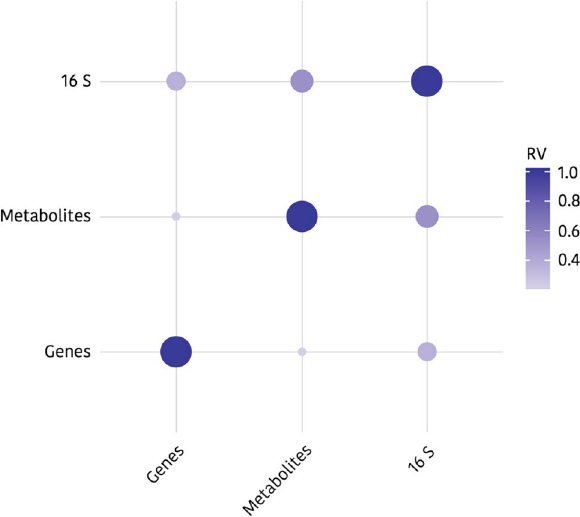
Figure 6. Correlation plot between gene expression (Genes), caecal microbiota (16 S) and metabolomic (Metabolites) datasets. The correlation between caecal microbiota and serum metabolome is much higher than with jejunal gene expression (Multivariate correlation values (RV): Genes & 16S = 0.37; Genes & Metabolites = 0.22; 16S & Metabolites = 0.53). Figure created by using open-source software R 21 v3.5.3. (https:// www.r- proje ct. org/ found ation/) and the LinkHD 22 package (https:// github. com/ lauzi ngare tti/